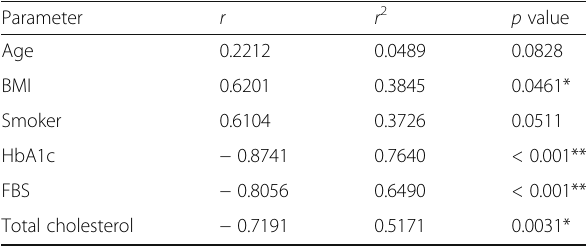
Table 4 Linear regression analysis of